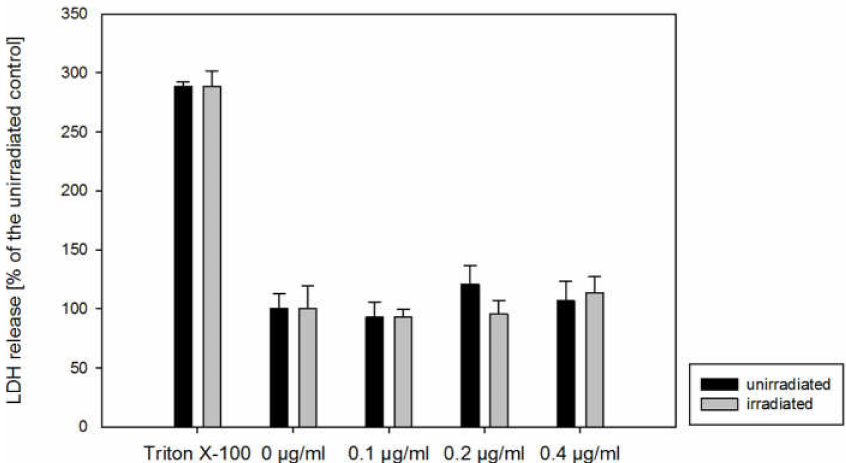
Figure 1. Lactate dehydrogenase (LDH) released from A498 renal cell carcinoma (RCC) cells incubated for 1 h with curcumin (0–0.4 µ g/mL) and irradiated with 5500 lx visible light for 5 min (grey) or kept light protected (black). Twenty-four hours later, cell supernatants were prepared. Each column represents the mean ± S.D. of a representative experiment done in triplicate. Cells treated with 1% Triton X-100 served as a positive control.